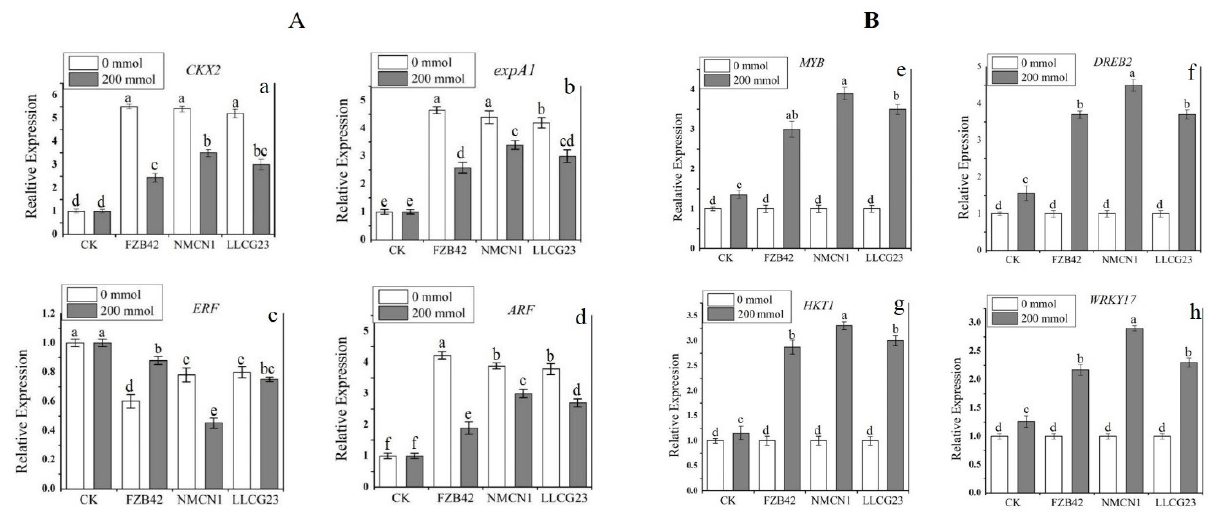
Figure 11. Effect of Bacillus strains on the expression of growth-promoting and salt-related genes in wheat plants grown under salt stress conditions (200 mmol). ( A ) Shows the expression profile of growth promoting genes ( a – d ) in wheat plants. ( B ) Indicates the expression analysis of salt-related genes ( e – h ) in wheat plants inoculated with Bacillus strains under saline condition (200 mmol). The error bars on the graphs indicate the standard deviation of the mean ( n = 3). The small letters were used to show significant difference among the treatments calculated through Tukey’s HSD test at p ≤ 0.05. The experiment has repeated three times with three replicates for each treatment.